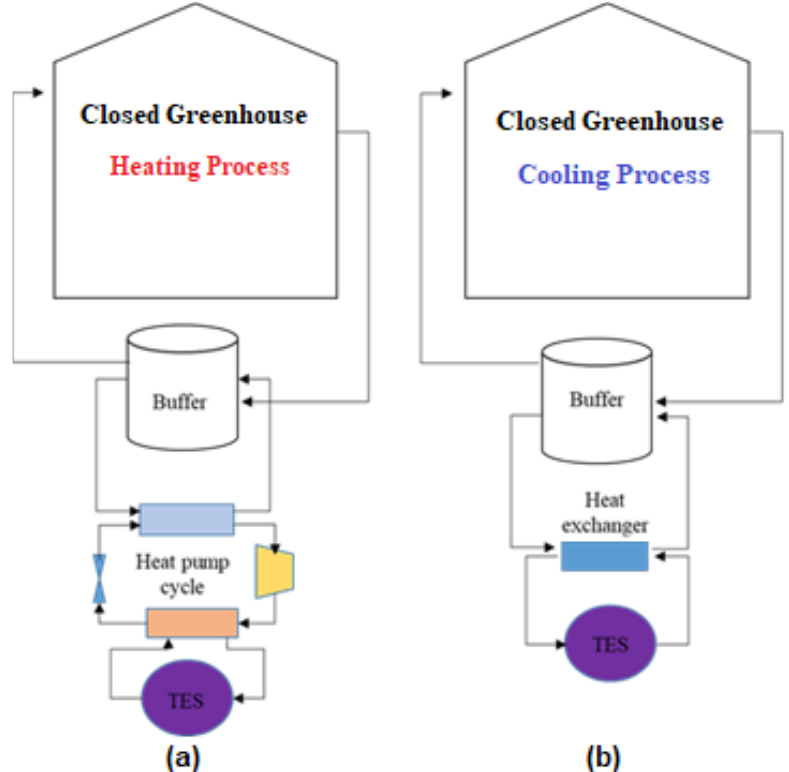
Figure 2. Heating and cooling processes in a closed greenhouse using TES system, ( a ) heating mode, ( b ) cooling